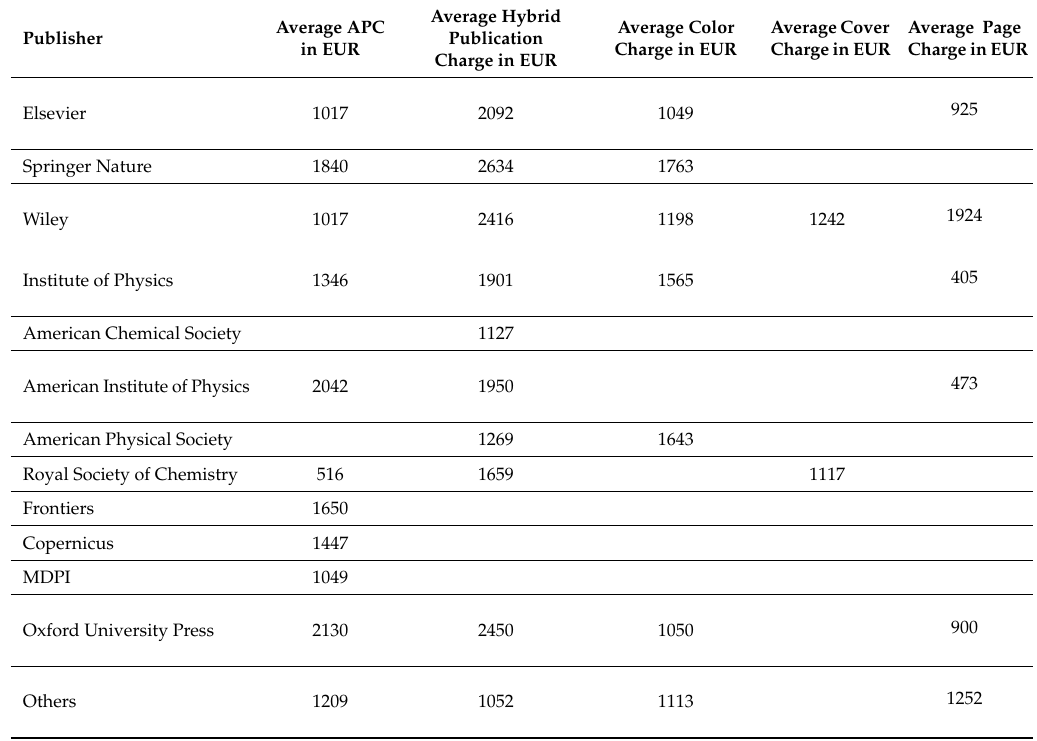
Table 2. Average publication expenditure by type of cost.